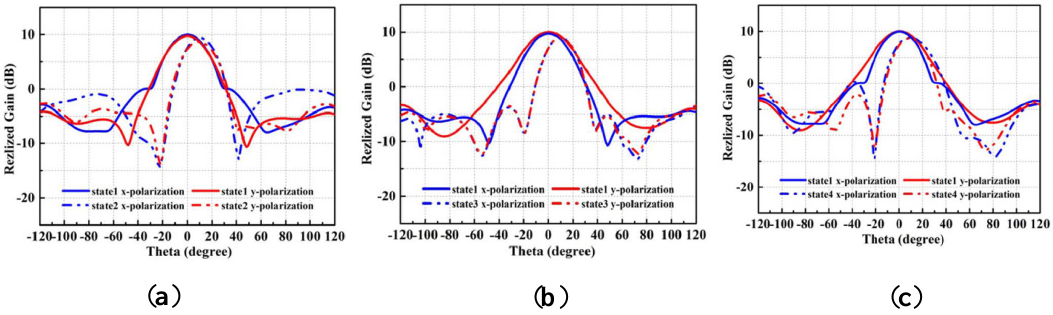
Figure 15. Radiation patterns of the RCA structure reported in [140] at three different planes: ( a ) 0 ◦ ; ( b ) 45 ◦ ; ( c ) 90 ◦